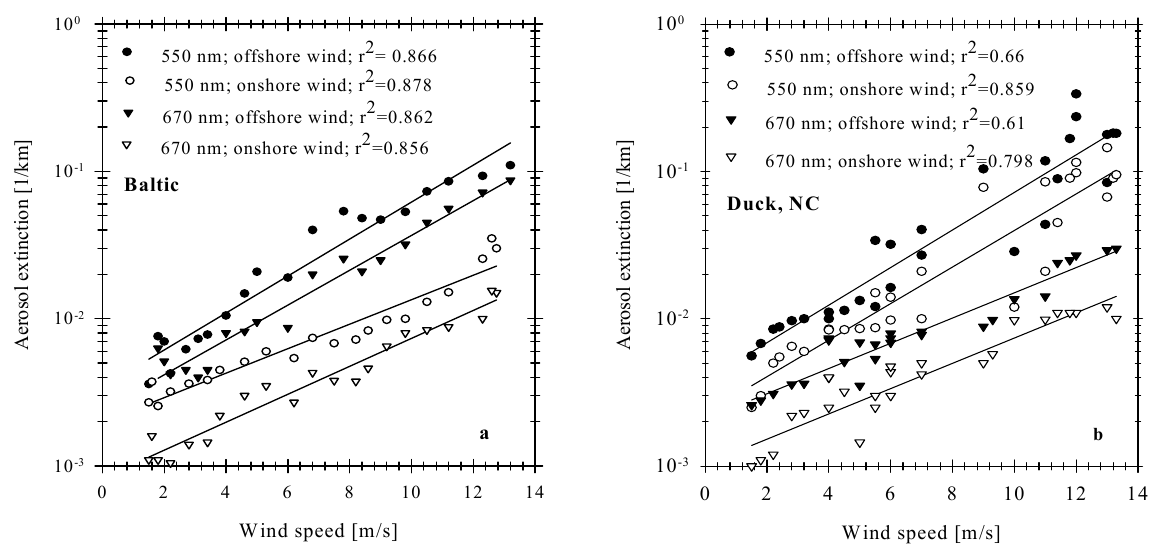
Figure 3. Aerosol extinction coefficients measured with the FLS-12 lidar at 10 m a.s.l. and at 550 and 670 nm in Lubiatowo (Baltic) (a) and in Duck, NC (b).